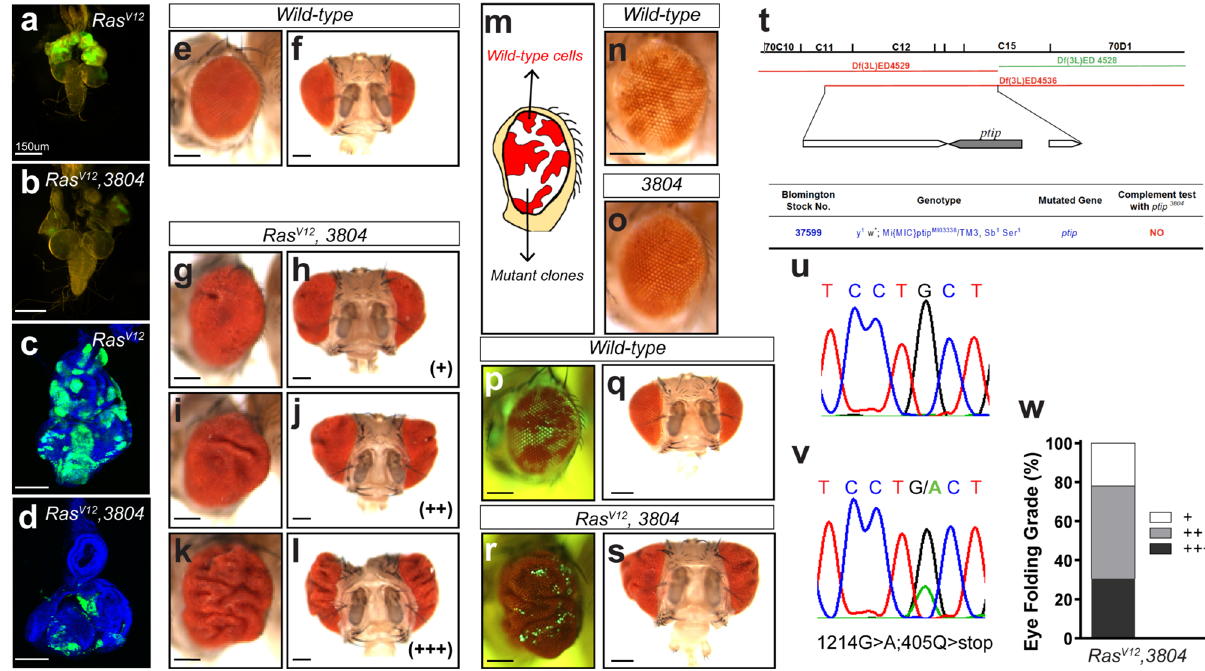
Fig. 1 Ptip − / − cooperates with oncogenic Ras to induce nonautonomous tissue overgrowth. ( a – d ) Mutation 3804 suppresses Ras V12 -mediated tumor overgrowth. ( a , b ) Images of third-instar larvae cephalic complexes showing GFP-marked Ras V12 ( a ) or Ras V12 3804 ( b ) clones. Images of eye imaginal discs dissected from third-instar larvae cephalic complexes and containing Ras V12 or Ras V12 3804 GFP-positive clones are shown in ( c ) and ( d ), respectively. Scale bars are 150 µ m. ( e – l ) Side and frontal images of adult fl y eyes. The nonautonomous overgrowth phenotype was categorized into three grades based on the severity of the phenotype ( + : weak; ++ : moderate; +++ : strong). ( e ) and ( f ) represent adult eyes from wild-type animals. The adult eye tissues bearing Ras V12 3804 double mutant clones showed varying grades of tissue folding ( g – l ). ( m – o ) Mosaic adult eyes bearing wild-type cells and mutant clones marked by a lack of pigmentation. A schematic of the mosaic adult eye is presented in ( m ). Wild-type cells ( n , white color) contribute ~50% to the eye fi eld, whereas the 3804 mutant clones ( o ) are barely detectable. ( p – s ) Matched light and fl uorescence images of adult eyes containing GFP-positive wild-type ( p , q ) or Ras V12 3804 double mutant clones ( r , s ). ( t ) Genetic complementation test of the ptip − / − mutation using overlapping chromosomal de fi ciency lines. The de fi ciency line shown in green complements the ptip − / − mutation, while the de fi ciency lines marked in red fail to complement. ( u , v ) Sequence results showing a G > A mutation in PTIP , causing a premature stop sequence. ( w ) Quanti fi cation of ( g – l ). All scale bars are 150 µ